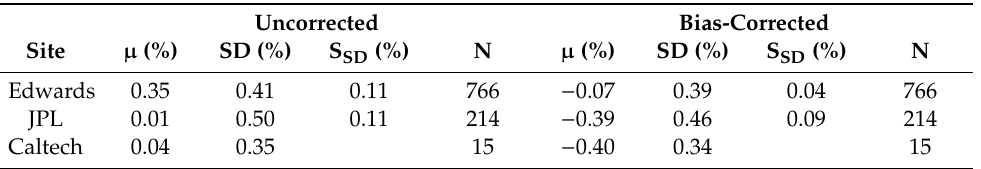
Figure A4. Similar to Figure 1a but for GOSAT data acquired with gain M: ( a ) bias-uncorrected; ( b ) bias-corrected. Table A3. The relative difference in the ratio component between GOSAT (gain M) and TCCON ( Δ ratio ) for each site: mean ( μ ), standard deviation (SD), and interseasonal bias (S SD ) of Δ ratio and the number of matched GOSAT and TCCON data points (N) are shown.